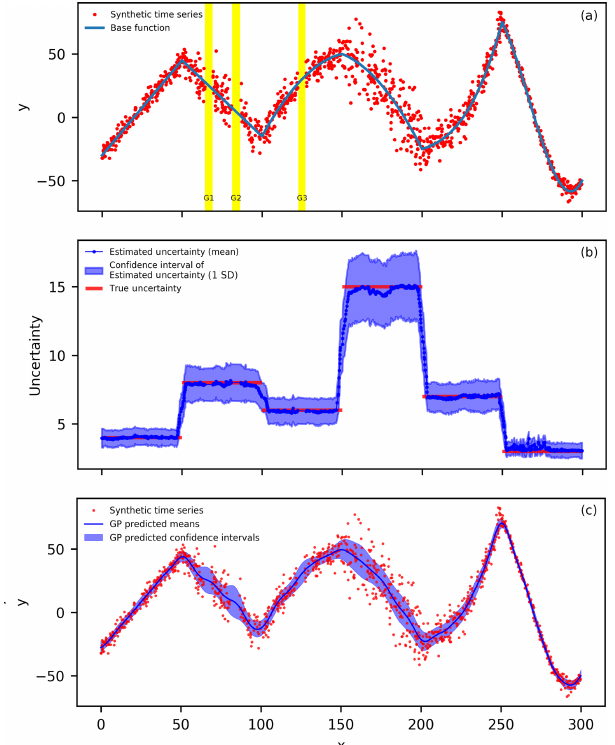
Figure 2. (a) The synthetic time series based on Eq. (10) (the blue line) with varying noise levels. There are originally 200 samples within every 50-wide interval (or segment) in the x coordinate, but points between [64.2, 69.2] (highlighted in yellow, G1), [80.8, 85.8] (highlighted in yellow, G2), and [122.5, 127.5] (highlighted in yel- low, G3) are removed to simulate data gaps in practice. The final number of points in the sequence is 1140. (b) The means (dark blue circles) and confidence intervals (light blue area) of the estimated uncertainty for the 200 synthetic sequences (all sampled from the distribution of (a) but with different random noise). The true uncer- tainty (red line segments) is also displayed. (c) The Gaussian pro- cess regression results for the synthetic time series from (a) . The dark blue line is the predicted mean function and the light blue area is the corresponding confidence